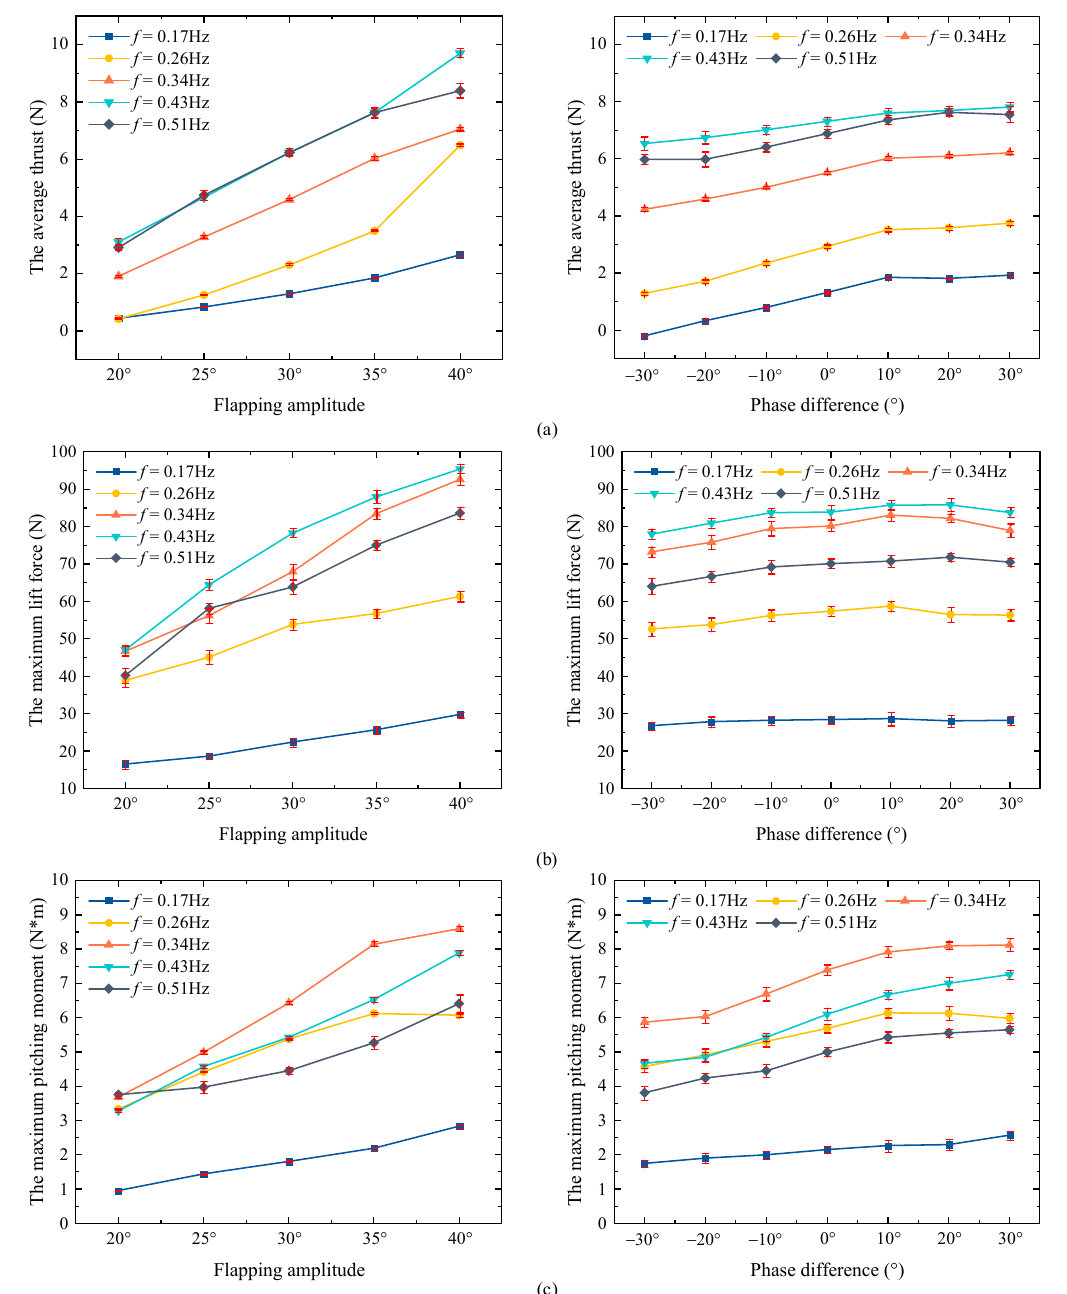
Figure 10. Influences of different oscillation parameters on the hydrodynamic performance. ( a ) The influence on average thrust. ( b ) The influence on the maximum lift. ( c ) The influence on the maximum pitching moment.